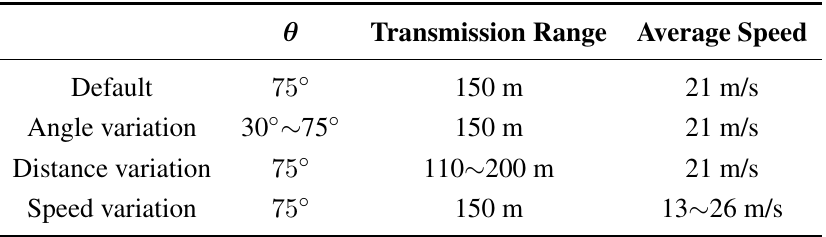
Table 2. The values of simulation